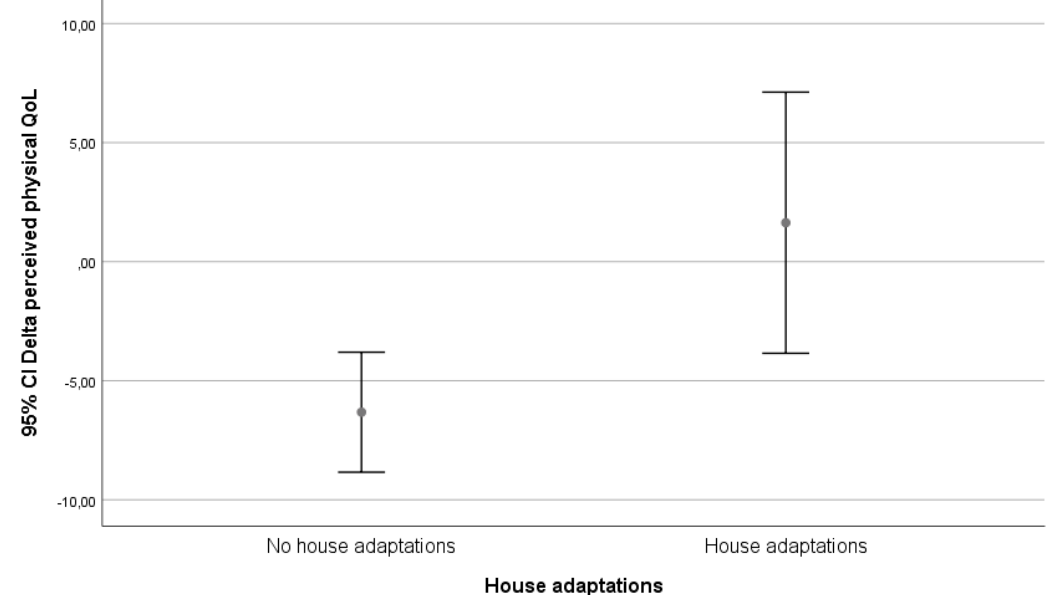
Figure 2. Relation between delta perceived physical health (SF-12 (physical health T12) − SF-12 (physical health T0) ) and match to in-house adaptations.